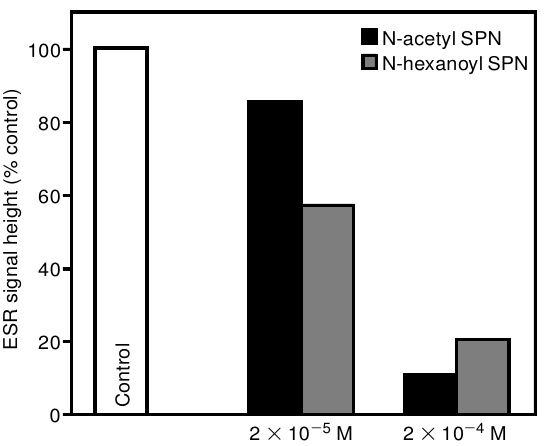
FIG. 3. Effects of two sphingosine analogues (N-acetyl SPN and N-hexanoyl SPN) on free radicals produced by stimu- lated-PMN (6 3 10 6 cells / ml). Spin trap (DMPO (100 mM), activator PMA (5 3 10 - 7 M).